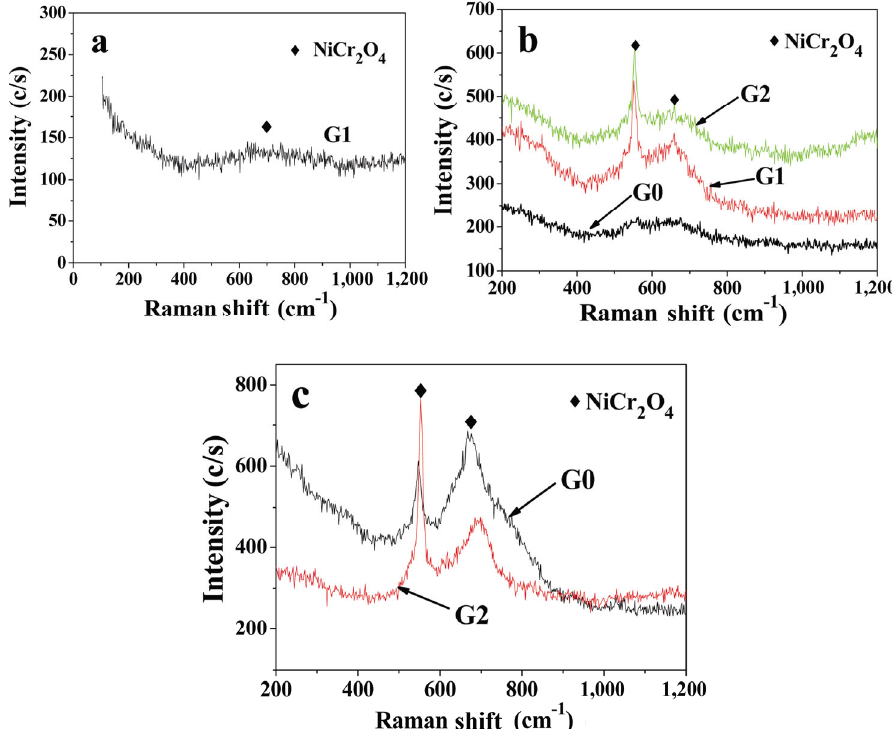
Fig. 12 Raman spectra of the worn surfaces for nickel-alloy matrix composite at different temperatures: (a) 400ºC, (b) 600 ºC, and (c) 800 ºC.